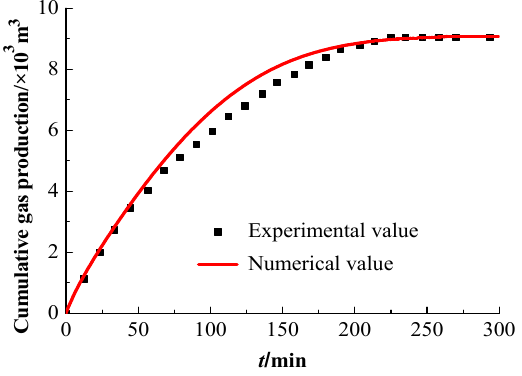
Figure 5. Comparison of experimental and numerical results of cumulative gas production.